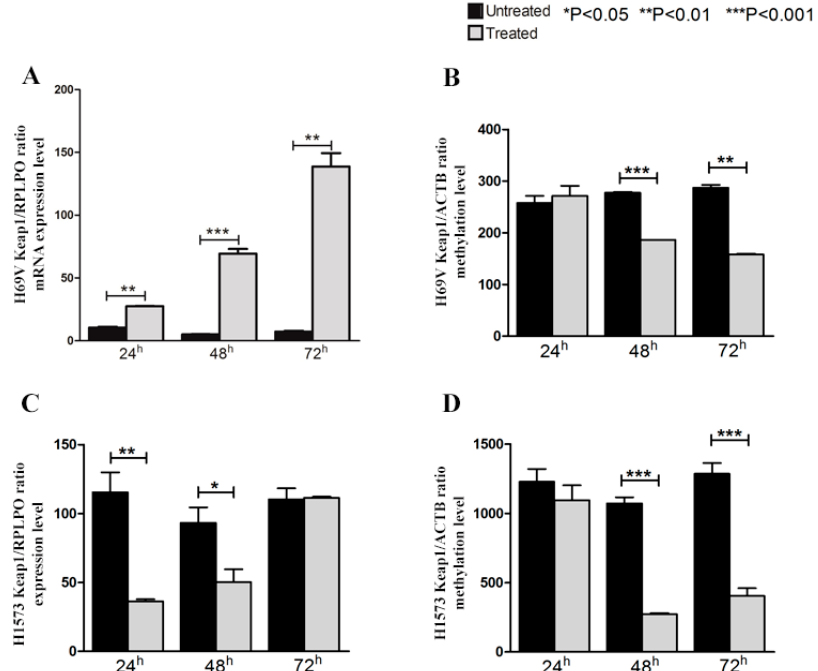
Figure 4. Changes in KEAP1 mRNA transcript levels in the ( A ) H69V, ( C ) H1573 cell lines by RT-PCR